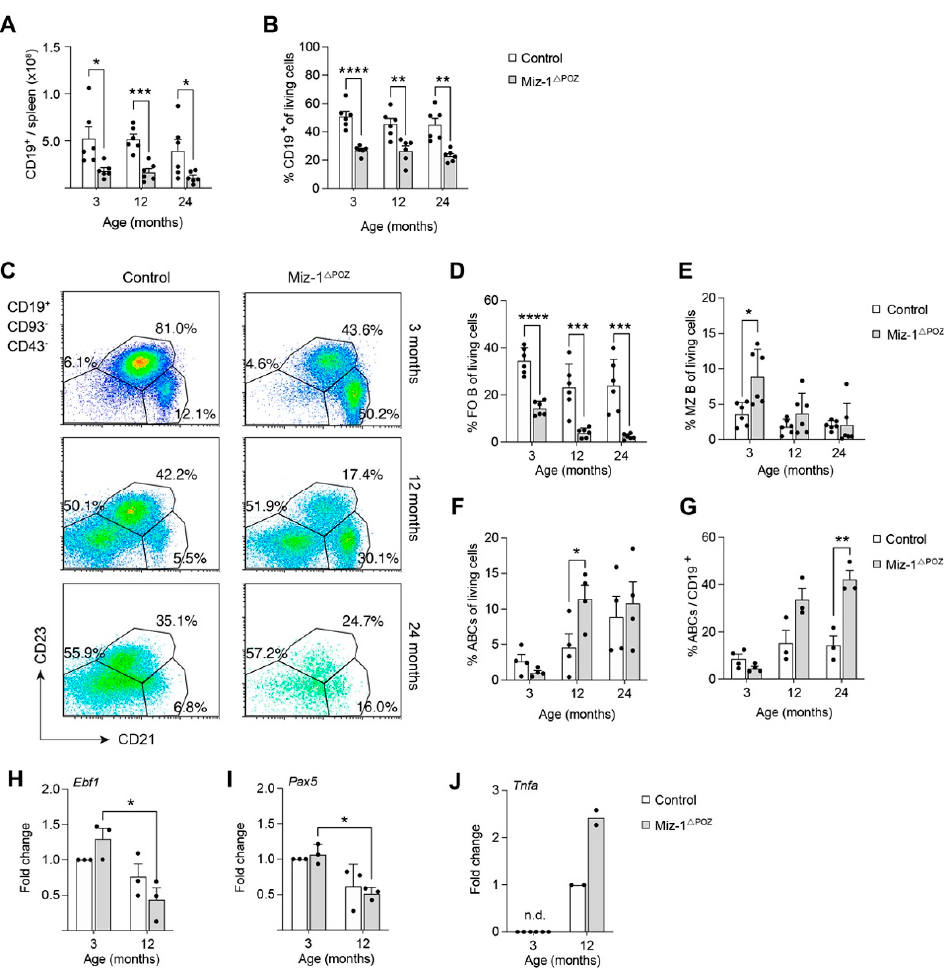
Figure 4. Miz-1 plays a role in fate decisions of peripheral B lymphocytes in aged mice. ( A ) Quanti- fication of splenic CD19+ B cells. ( B ) Frequency of splenic CD19+ cells in control and Miz-1 Δ POZ mice at different ages. ( C ) Flow cytometric analysis of splenocytes from control and Miz-1 ∆